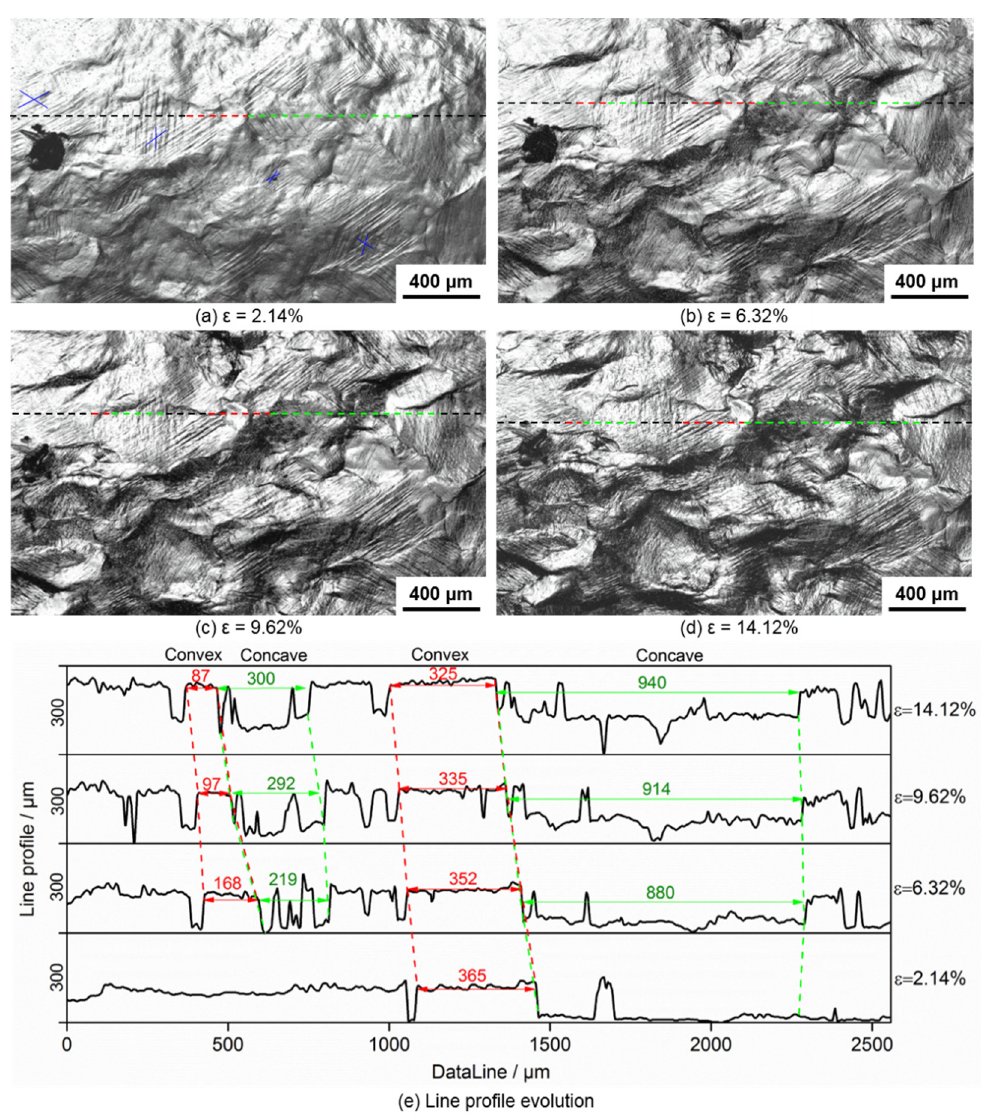
Figure 3. Surface morphologies of the marked area when the sample was stretched to global strains of ( a ) 2.14%; ( b ) 6.32%; ( c ) 9.62%; ( d ) 14.12%; and ( e ) line profile evolution.